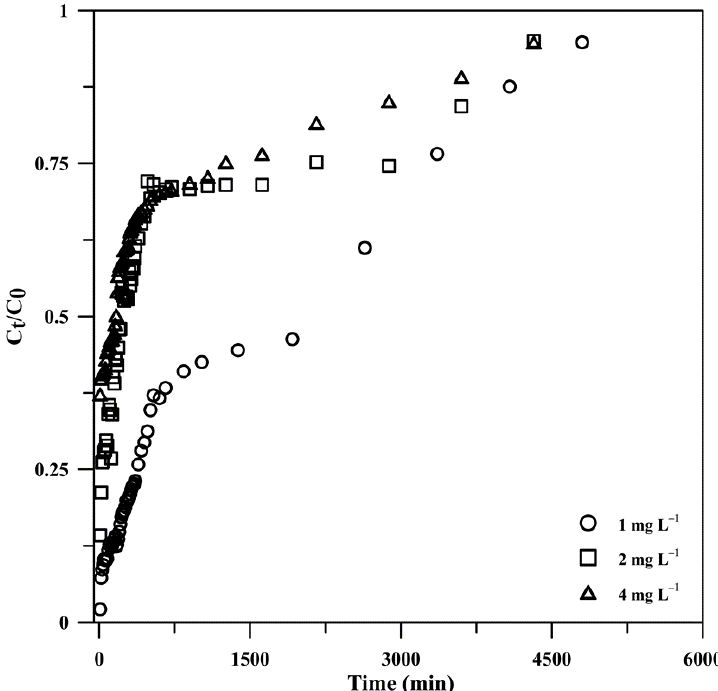
Figure 6. Breakthrough curves for phosphate adsorption onto Cry – CSH at different phosphate concentrations ( C t / C 0 is the ratio of effluent phosphate concentration at time t to the influent phosphate concentration). Table 2. Influence of the phosphate initial concentration on experimental breakthrough parameters for phosphate adsorption by monolithic Cry – CSH.